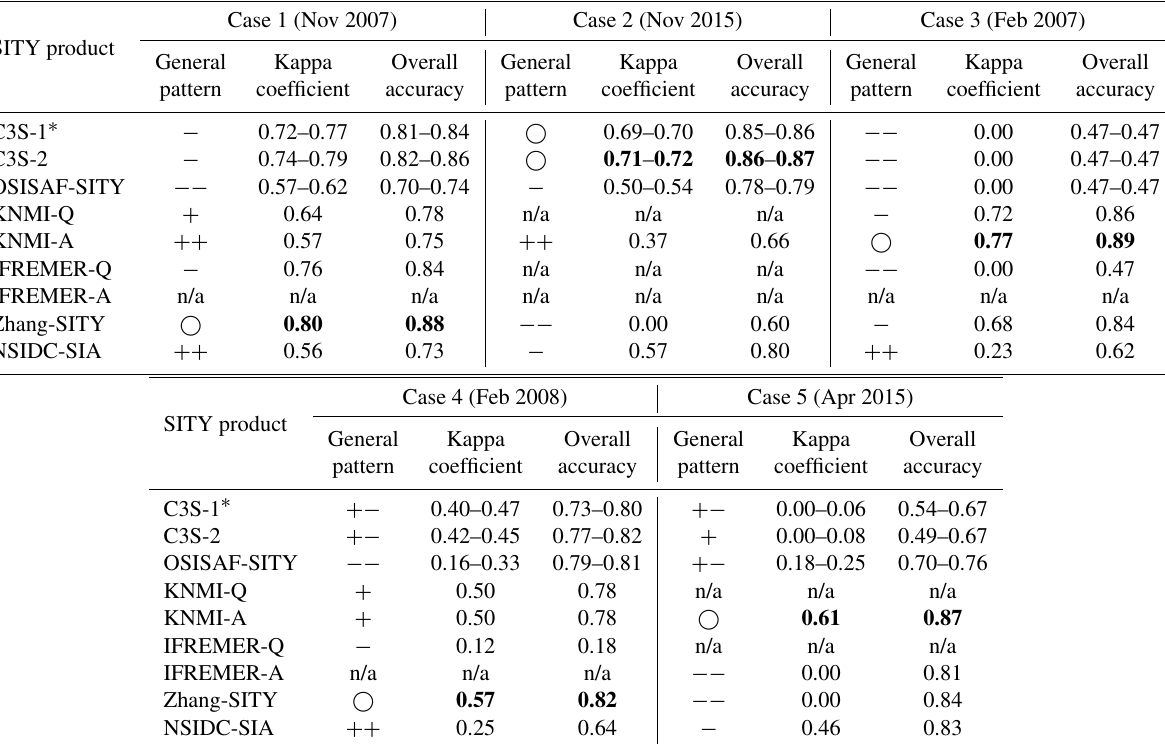
Table 4. Performances of the SITY products compared to SAR images. Bold font highlights the SITY product with the best performance in each